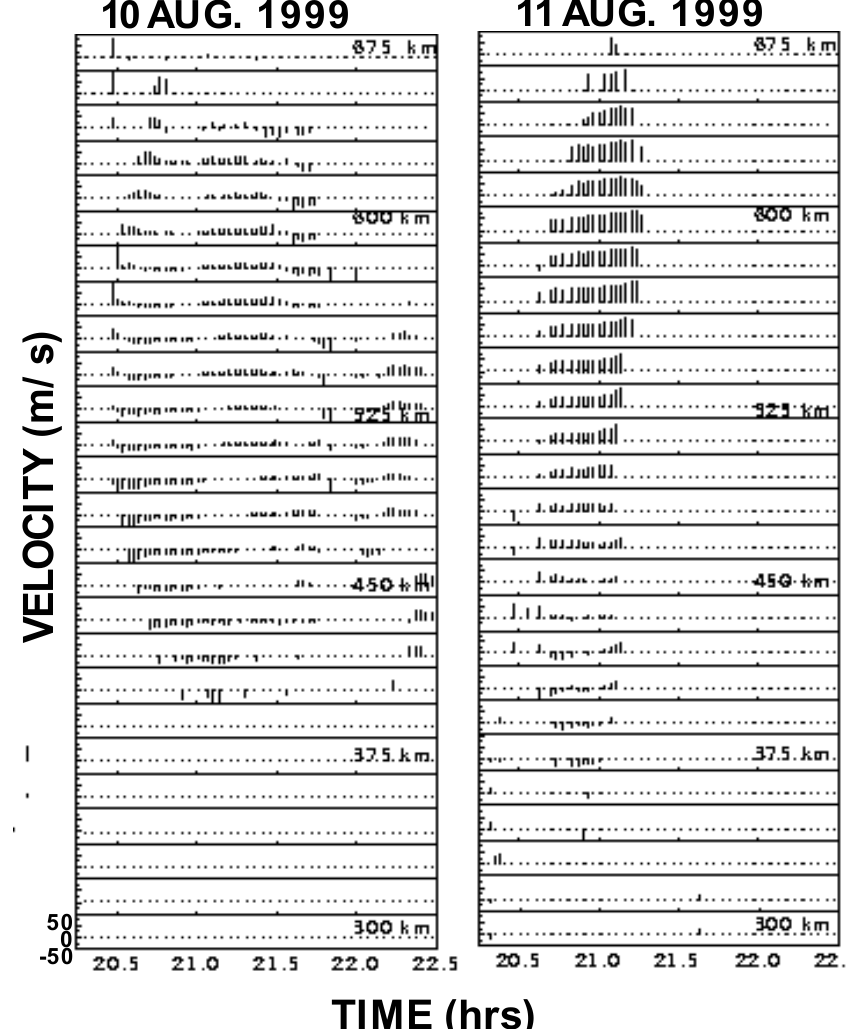
VHF radar observations in the past, during such events,